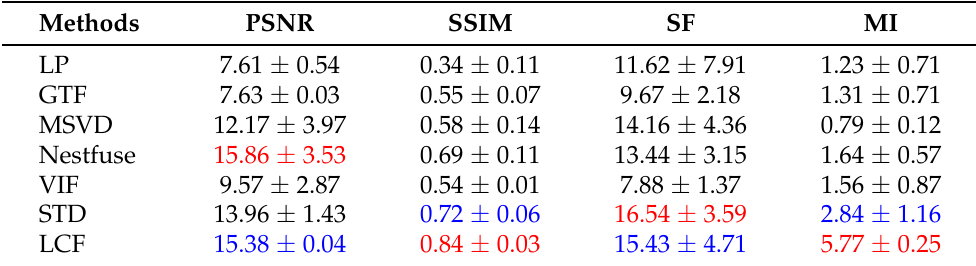
Table 2. Quantitative comparisons of different methods for the fusion of TNO dataset. Red indicates the best result, and blue represents the second best